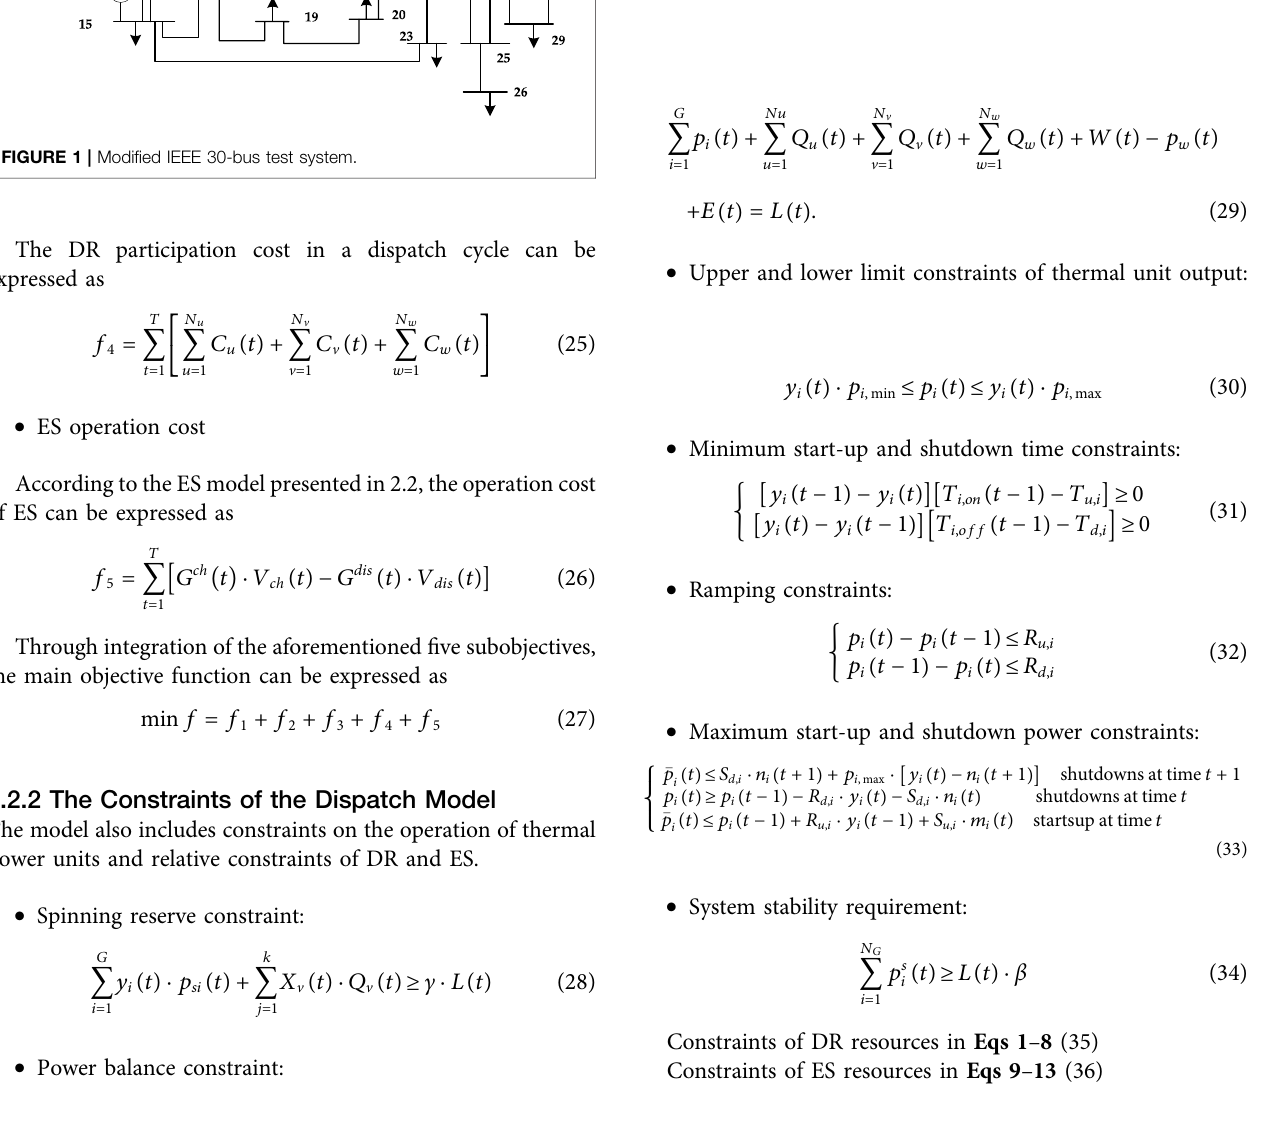
FIGURE 2 | Outputs of thermal units at each period in Scenario